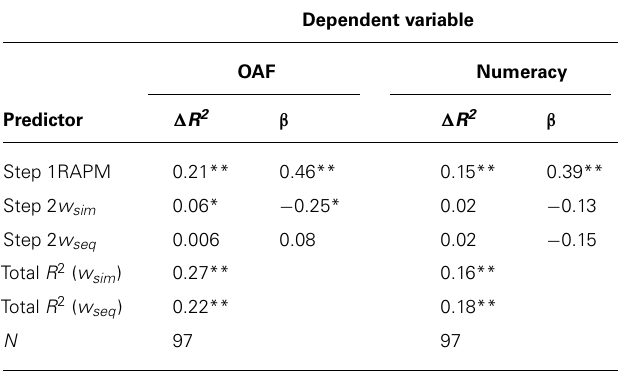
Table 2 | Hierarchical multiple regression models with overall arithmetic fluency (OAF) and Berlin NumeracyTest (numeracy) as dependent variables and Raven’s matrices (RAPM), Step 1, and simultaneous ( w sim ) or sequential ( w seq )ANS measures, Step 2, as predictors. Change in R 2 ( (cid:2) R 2 ), beta weights ( β ), and total R 2 are reported for the respective